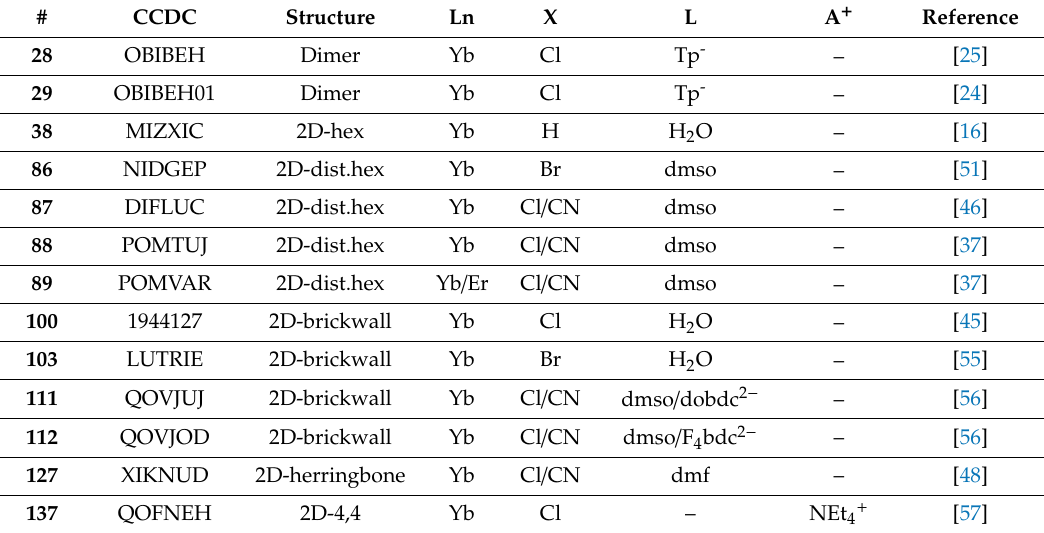
Table 26. Structurally characterized Yb(III) compounds with anilato ligands.